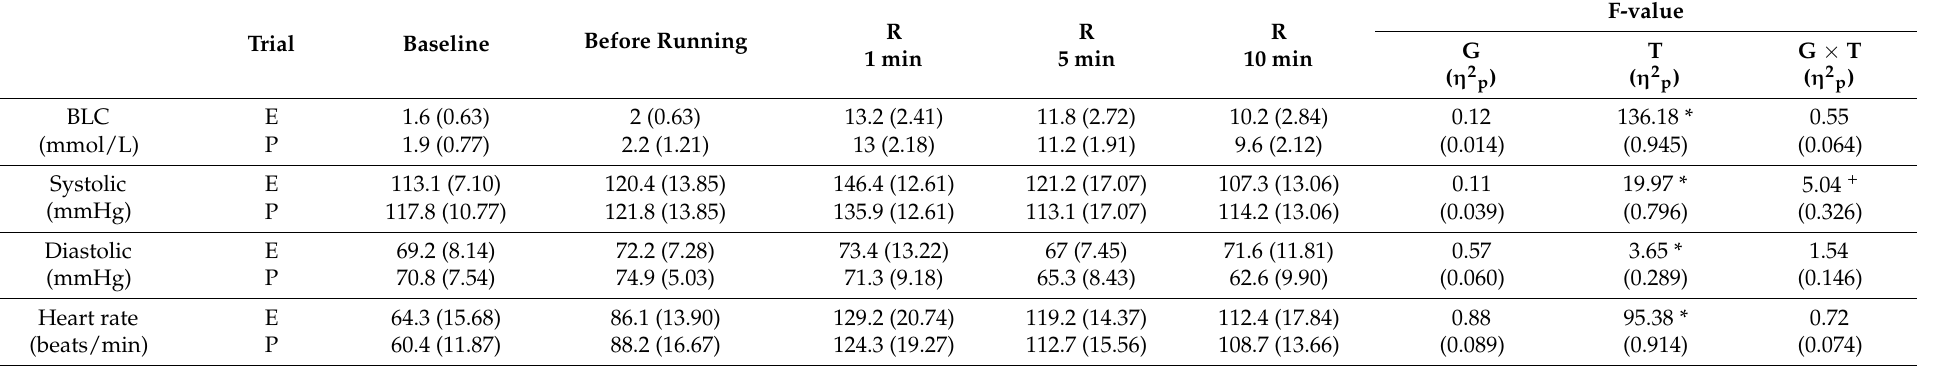
Table 2. Changes in blood lactate concentration, blood pressure, and heart rate during